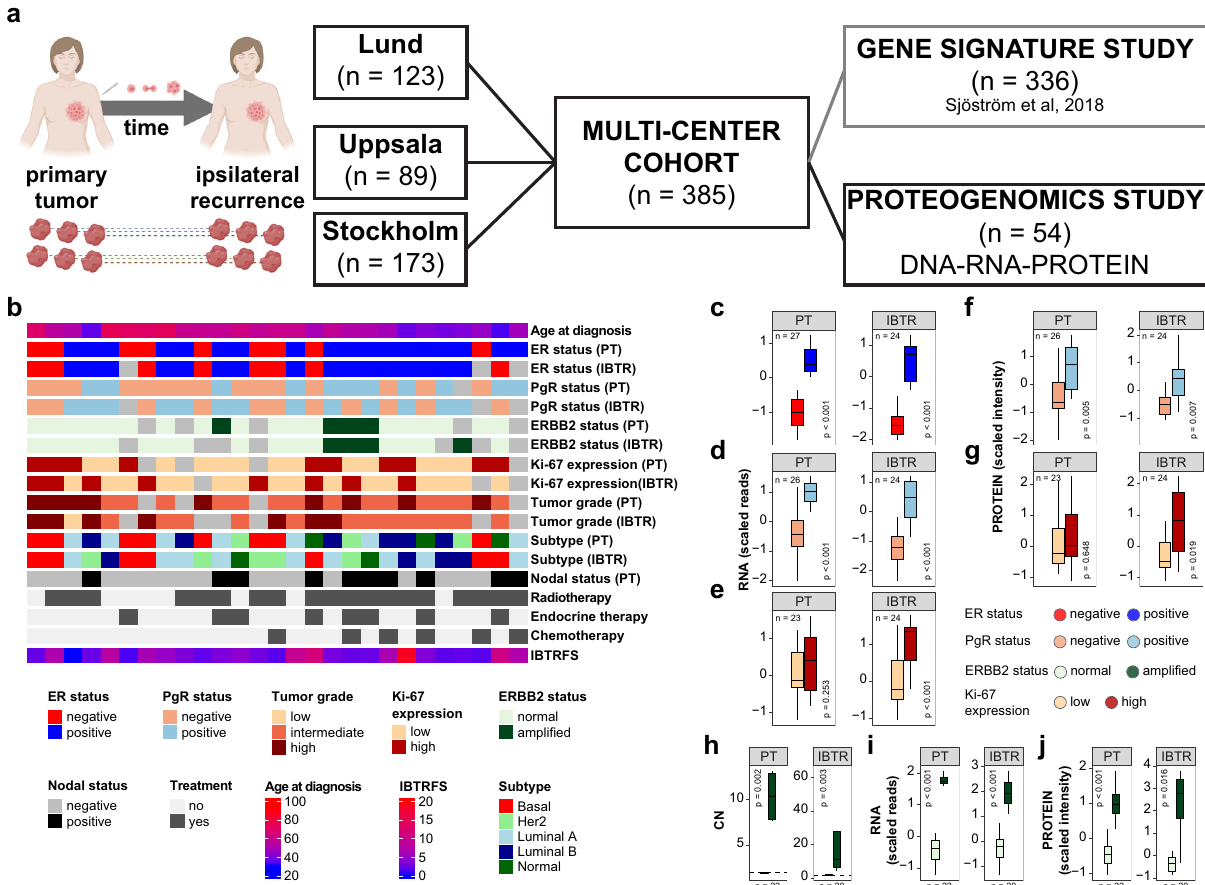
Fig. 1 Cohort selection and metadata. We selected a set of PTs and matched IBTRs ( n = 27 + 27) from a larger multi-center (Lund, Uppsala, Stockholm) study ( a ; this panel was created with BioRender.com). Clinical data and histopathological characteristics were registered upon sample collection or after analyses of paraf fi n-embedded material, if available. b Description of key clinical parameters (light gray boxes represent missing values). Frozen tumors were analyzed by WGS, RNAseq, and proteomics. Transcriptomic (RNAseq, c – e ) and proteomic (MS, f , g ) validation of IHC-based classi fi cation of ER, PgR, and Ki-67 levels. Panels h – j depicts CN (WGS, left), transcript (RNAseq, center), and protein (MS, right) levels for tumors with detected ERBB2 ampli fi cation. Number of samples included in each test depends on availability of clinical data. Boxplots depict distribution of values as quartiles. Line at the center of each boxplot depict the median value. CN, copy number; ER, estrogen receptor; ERBB2/Her2, receptor tyrosine-protein kinase erbB-2; Ki-67, antigen Ki-67; IBTR, ipsilateral breast tumor recurrence; IBTRFS, IBTR-free survival; MS: mass spectrometry; PgR, progesterone receptor; PT, primary